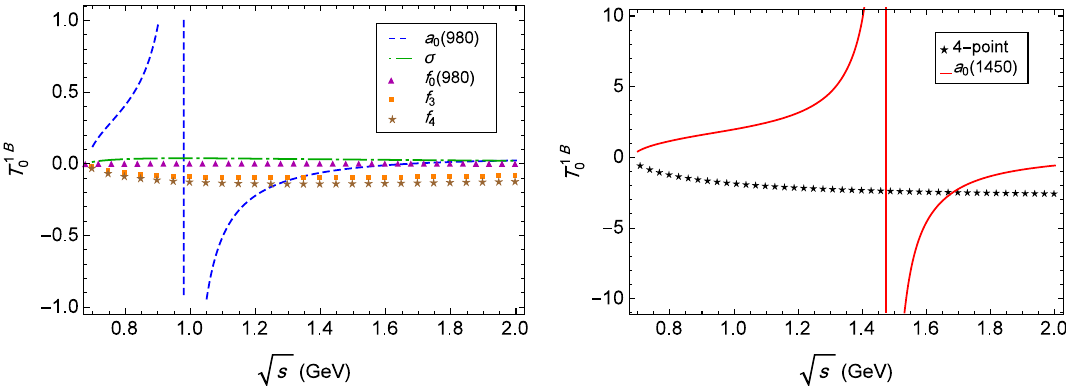
Fig. 8 Individual contributions to real part of the unitarized πη scattering amplitude for A 3 / A 1 = 30 and m [ π( 1300 ) ] = 1 . 38 GeV. (Note that the contributions are plotted into two figures to avoid overcrowding and to be able to show contributions that are of considerable size